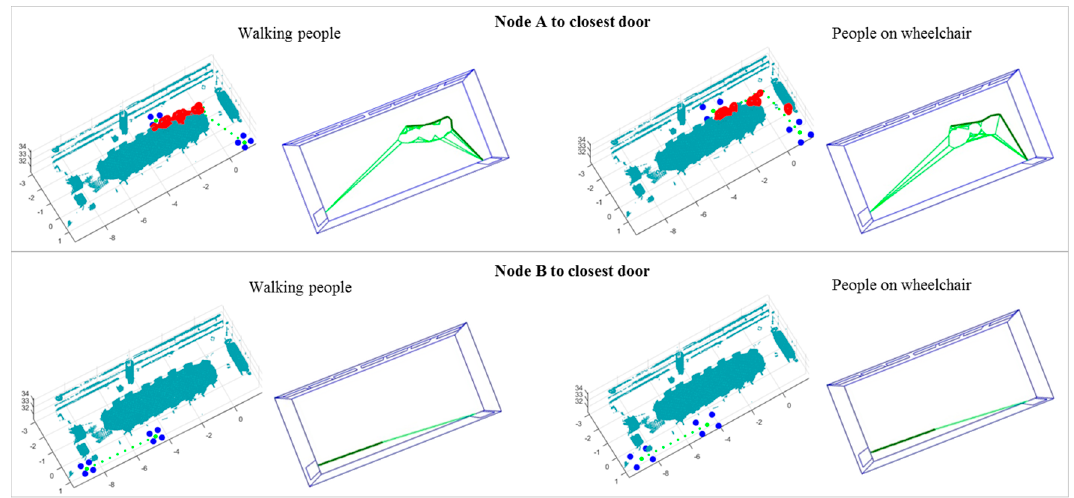
Figure 14. The resulting indoor paths are represented in green for the tests carried out inside the videoconference room (“Node A to closest door” and “Node B to closest door”) (units in meters).